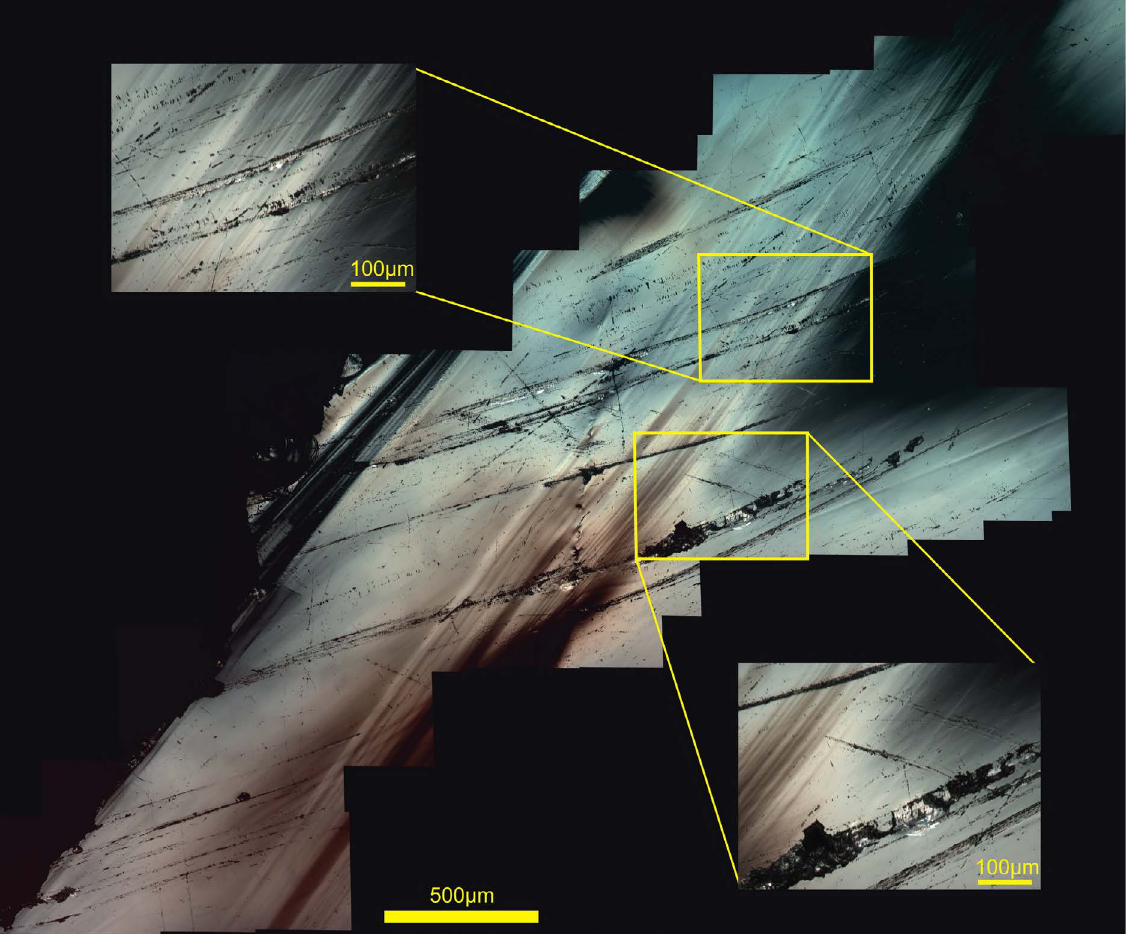
Figure 6. Gigapixel-like image (Gigapixel 1 in Figure 5); striations and percussion marks likely due to knapping